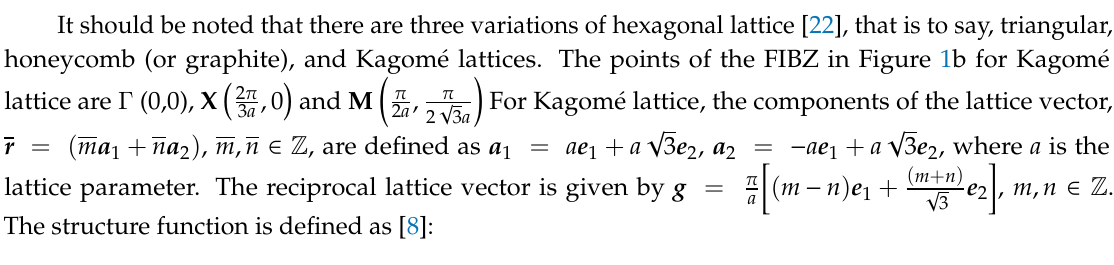
Figure 1. Transverse cross section area of the magnetoelectroelastic phononic crystal (MPnC) with Kagomé lattice ( a ). First irreducible Brillouin zone for Kagomé lattice ( b ).